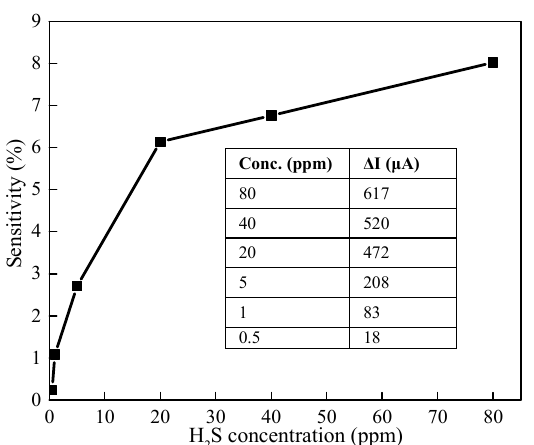
Figure 4. Sensor sensitivity ( S ) at 250 °C versus H 2 S concentration. The inset shows measured Δ I